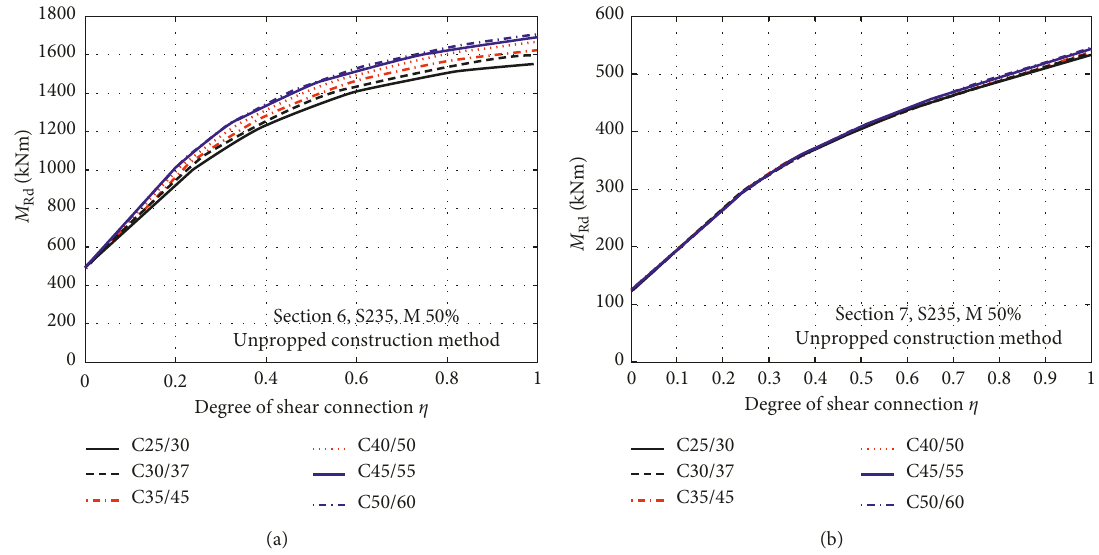
Figure 14: Effect of variation of class of concrete on resisting bending moment (degree of shear connection relation). Unpropped construction method. (a) Section 6 S235 M50% and (b) Section 7 S235